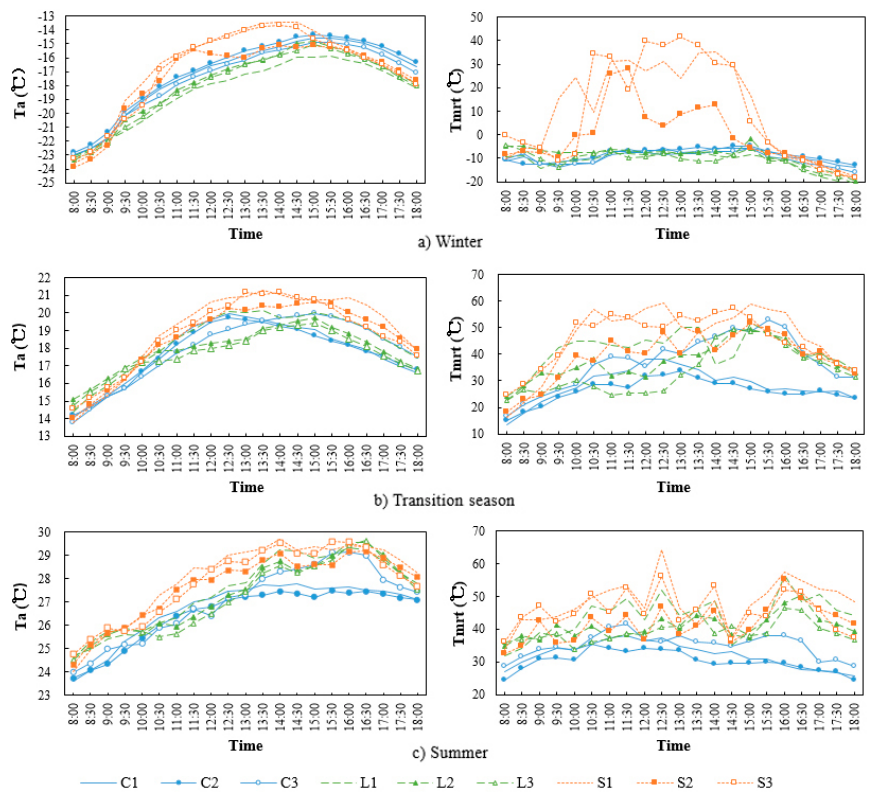
Figure 8. Temporal variation of air temperature and mean radiation temperature for each measurement point in di ff erent